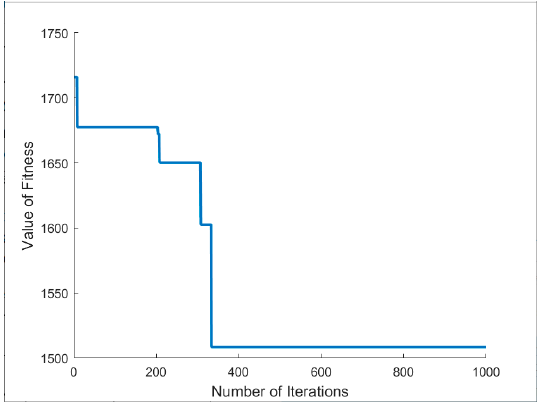
Figure 2. Convergence results of PSOSA algorithm.